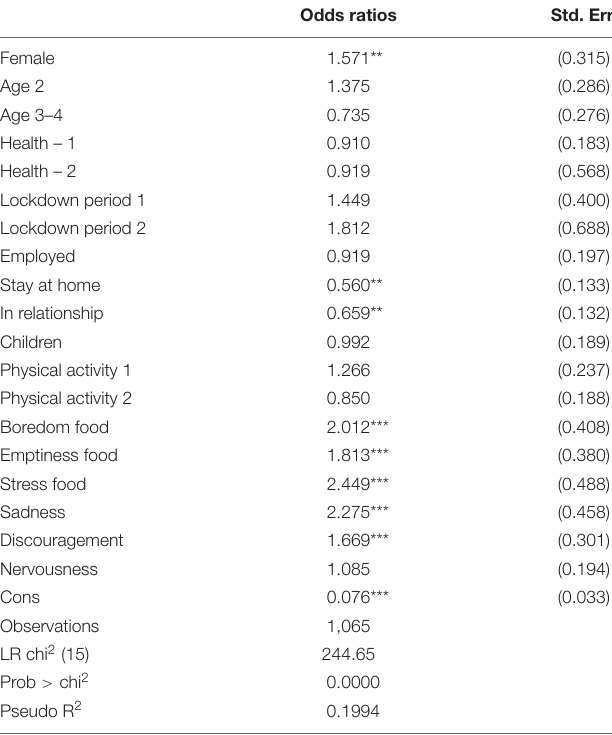
TABLE 3 | Logistic regression on eating loss of control.